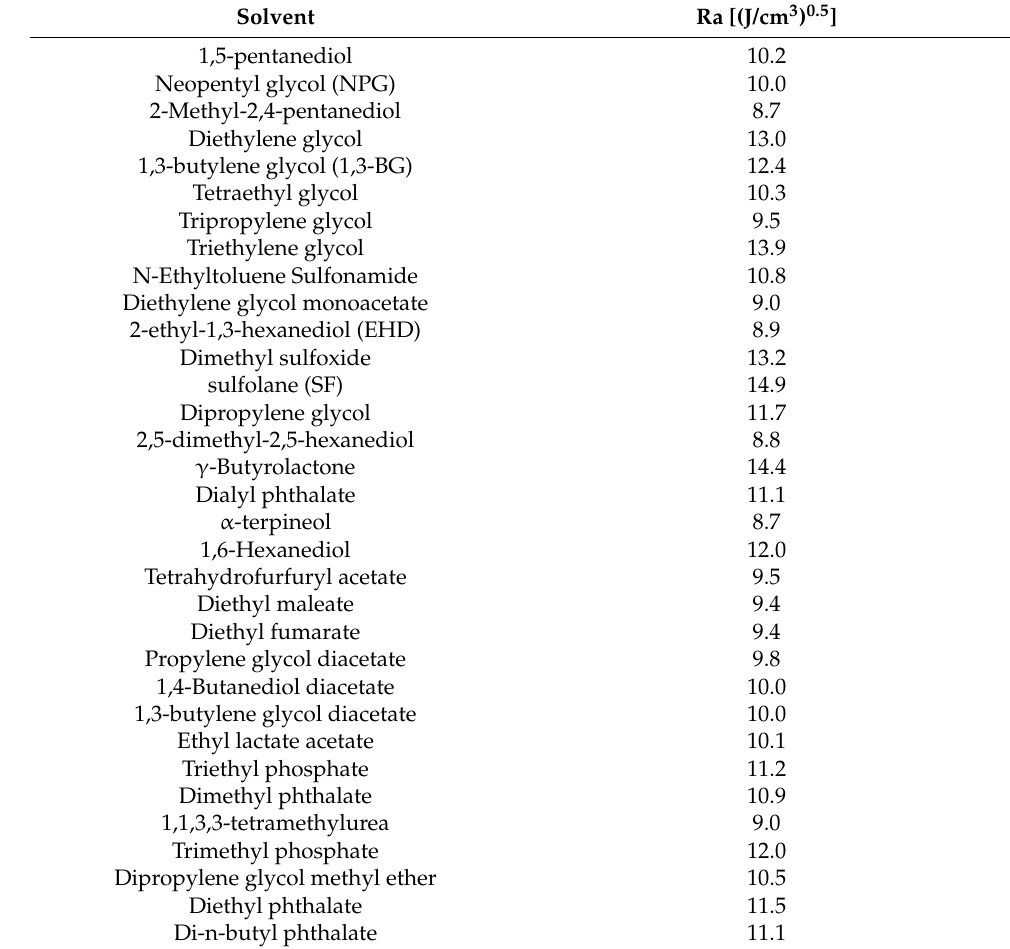
Table A2. Solvents dissolved CBzOH polymer at 170 ◦ C and Ra of the with the evaluated solvents (polymer concentration 25